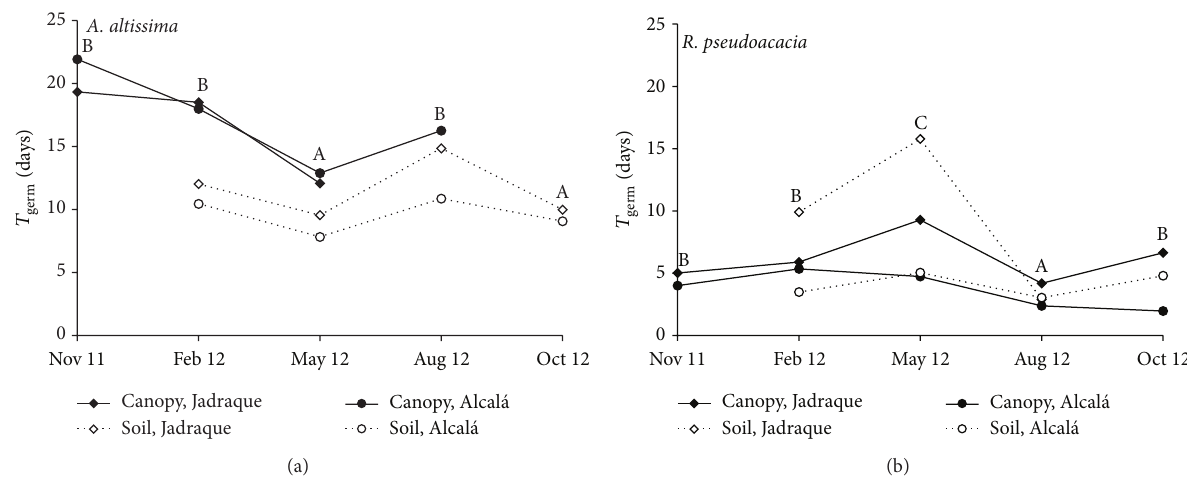
Figure 3: Time to germinate ( 𝑇 ) of Ailanthus altissima and Robinia pseudoacacia seeds from the canopy and soil seed banks from two germ populations (Jadraque and Alcal´a) throughout a year. Uppercase letters represent significant differences in 𝑇 (i.e., at different moments of the